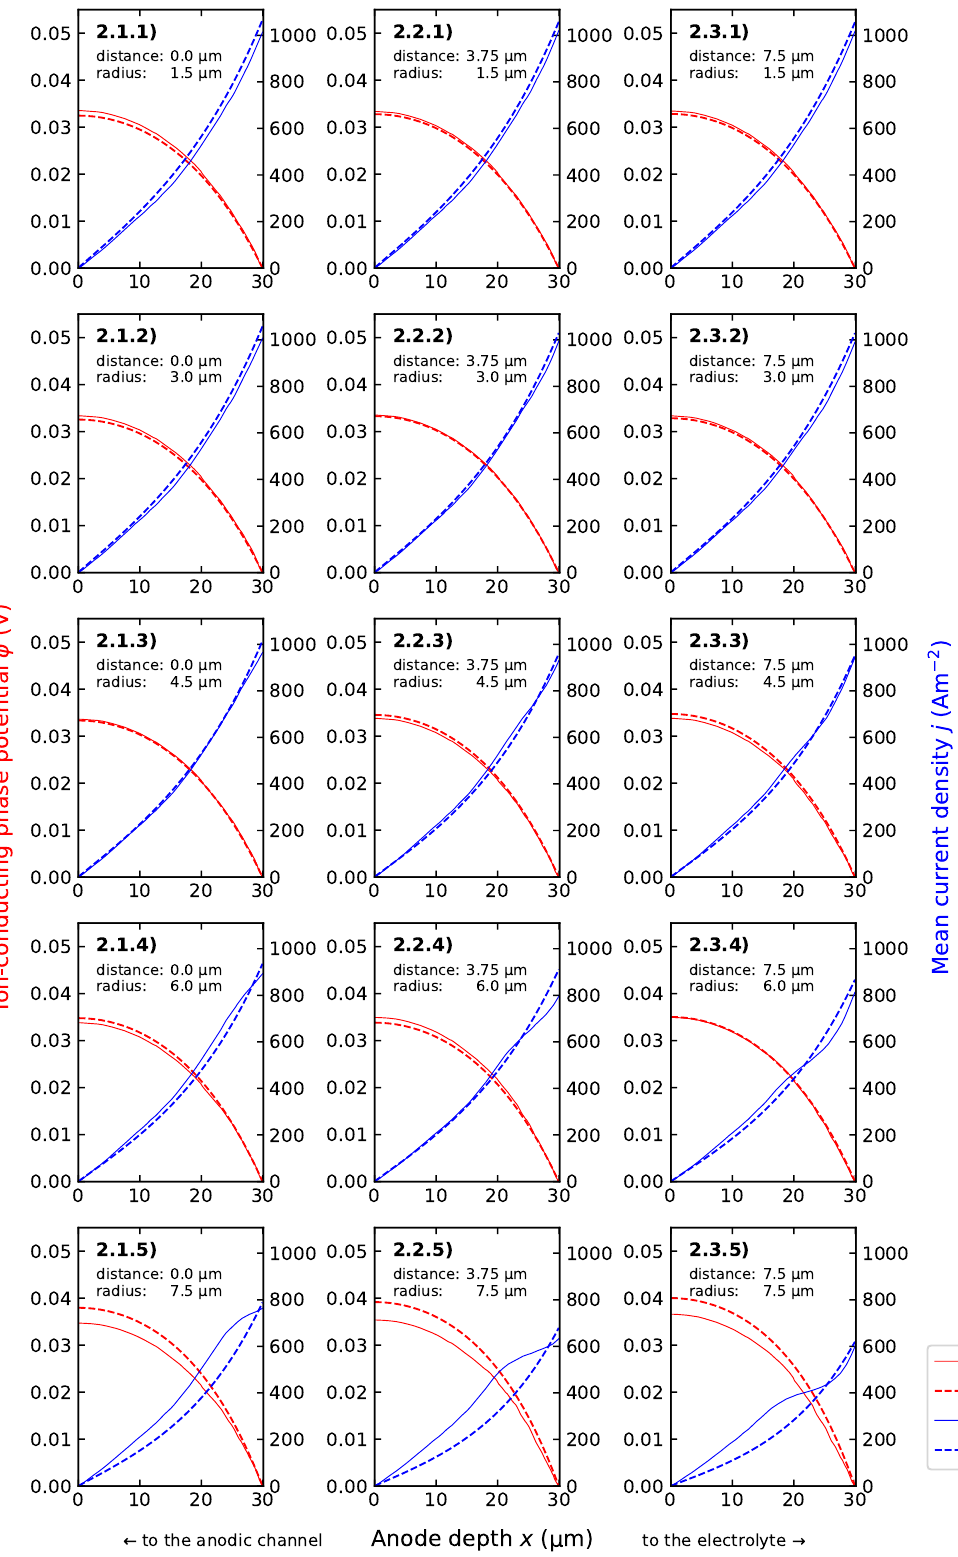
Figure 5. “Corner-type” non-conducting disturbance parametric study—ionic potential and exchange current density fields. Boundary conditions: φ el,b = 0.05 V, p H Thickness: 30.0µm. T = 1073